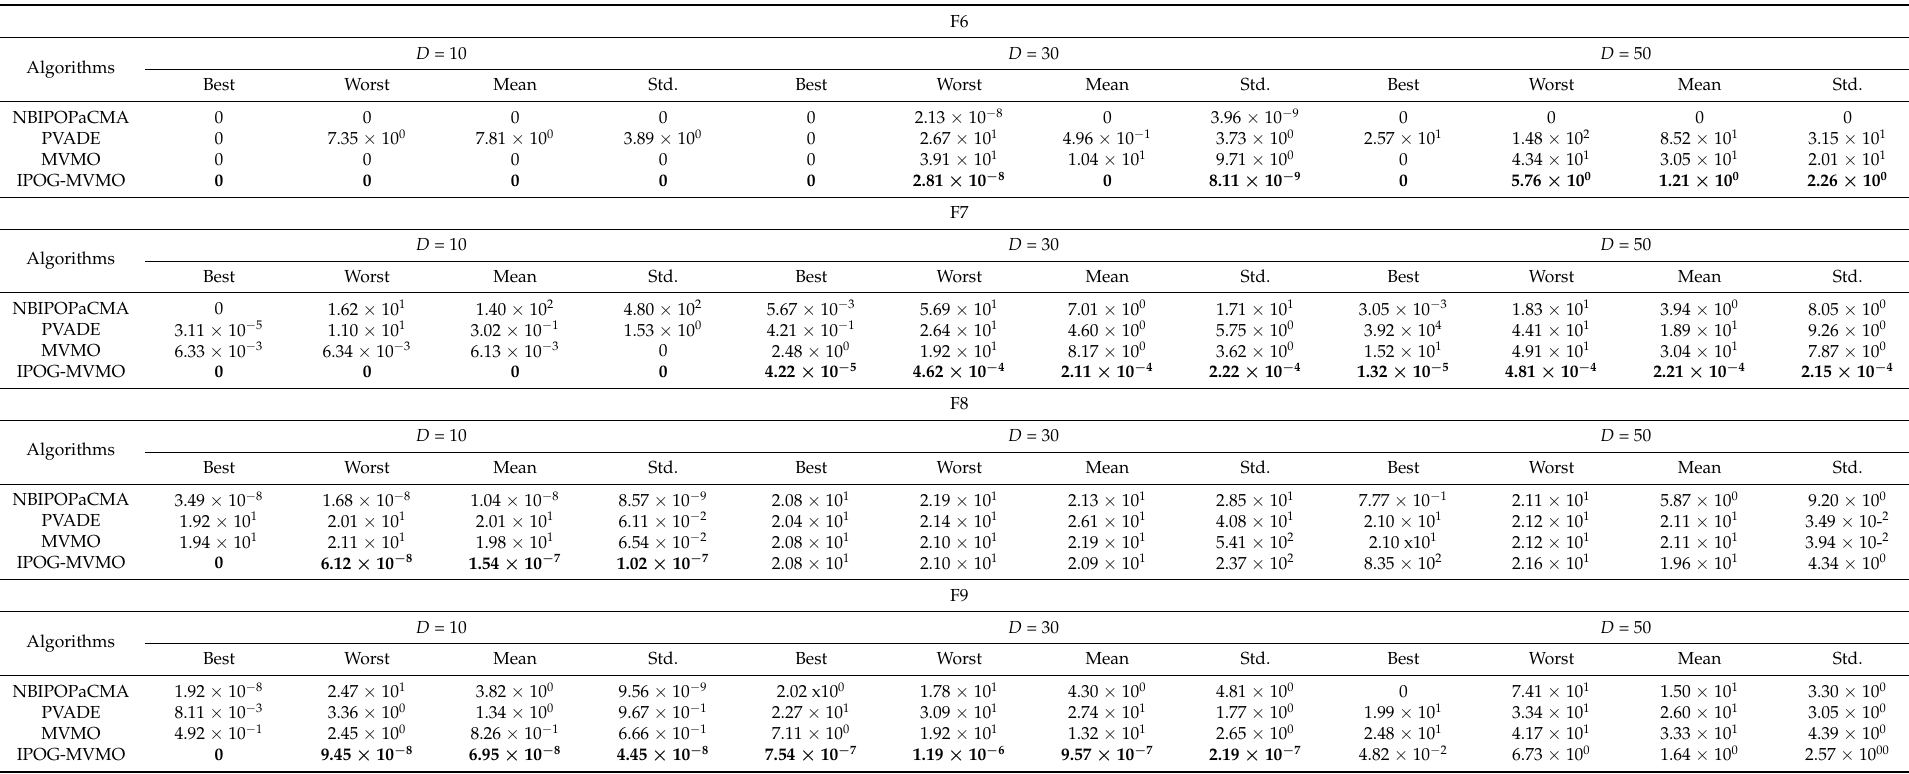
Table 3. The comparative results of the errors obtained from multimodal functions